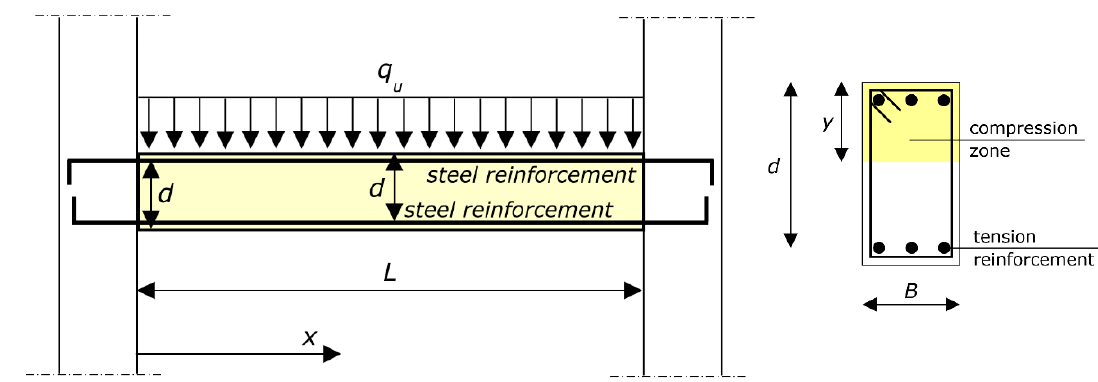
Figure 1. Reference structure. On the left: hyperstatically supported reinforced concrete (RC) beam (in the schematic, the beam is connected to vertical structures, e.g., columns or walls), and ultimate load qu . The end sections are at x = 0 and x = L (span). The effective depth is denoted by d . On the right: cross-section of the beam at midspan. The width is denoted by B . The neutral axis depth to effective depth ratio is denoted by y / d . The stirrups, which are not represented in the left diagram, have no role in the flexural behavior, since the concrete is unconfined or lightly confined.